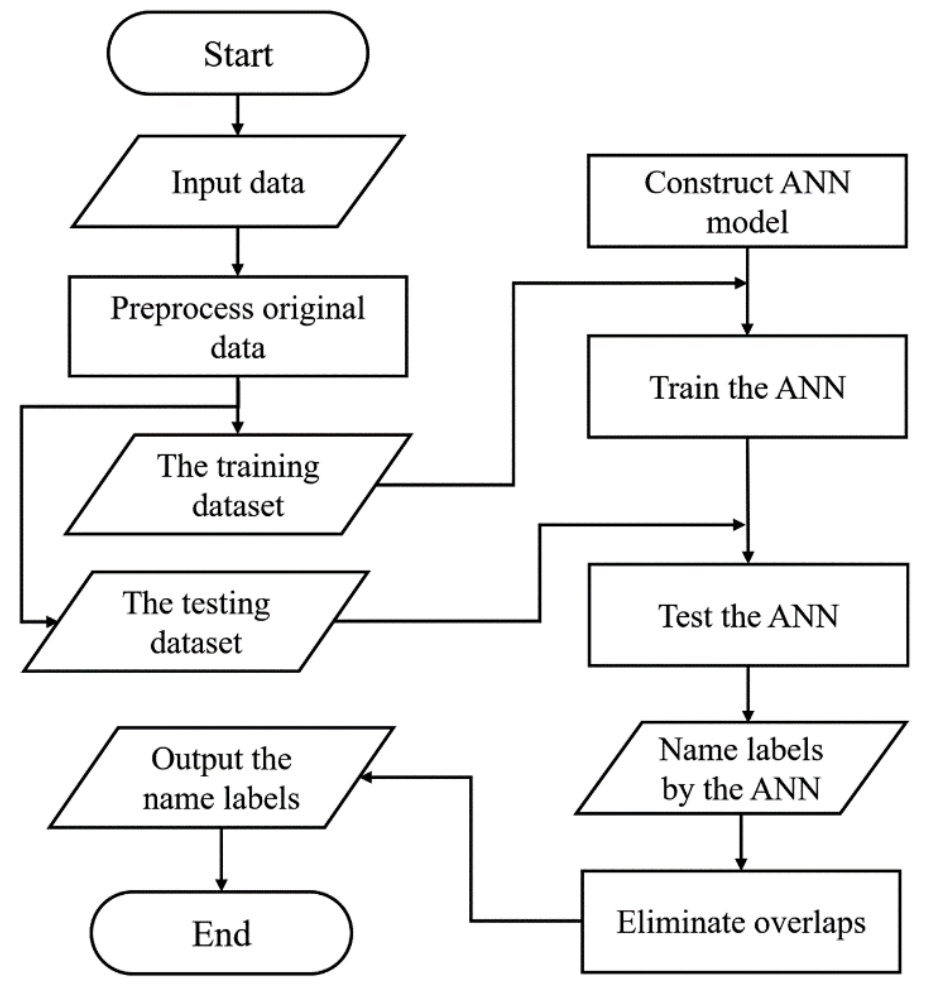
Figure 10. The whole process of using ANNs for labelling.